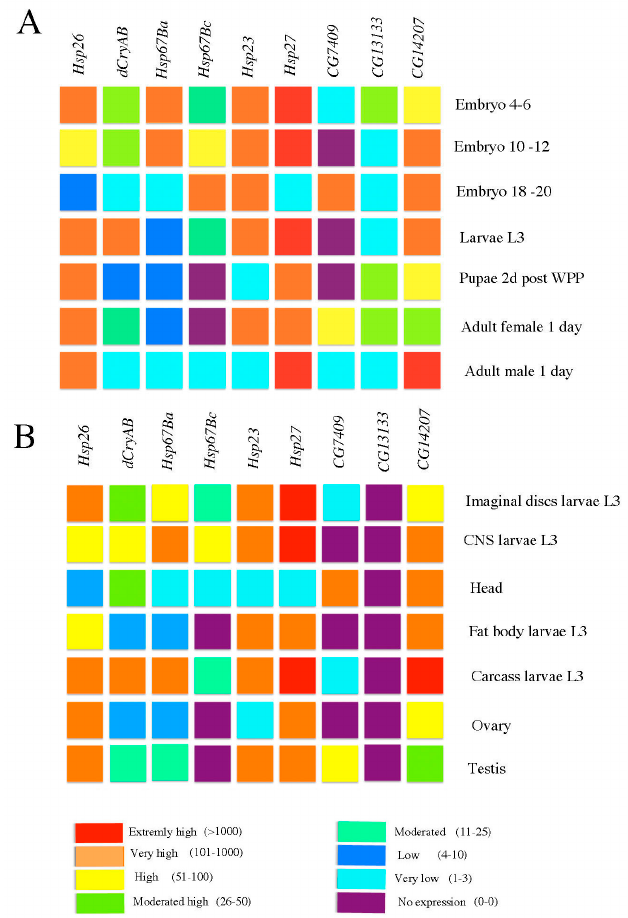
Figure 2. Time ( A ) and tissue-specific ( B ) Drosophila sHsp genes expression during development (adapted from the Flyatlas transcriptomic datasets presented in the Flybase). Color code of expression with signal level between brackets is indicated below the figure.